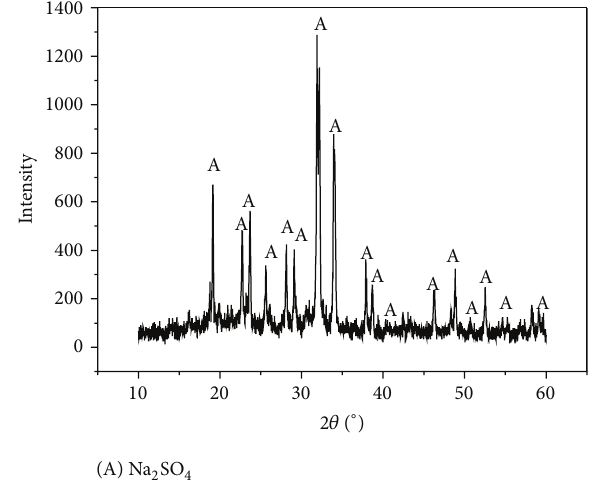
Figure 8: XRD pattern of the crystals from supernatant (SO 2 , 2500 ppm; gas flow, 0.12m 3 /h; absorption solution, 100 mL; O 2 , 5vol%; 25 ∘